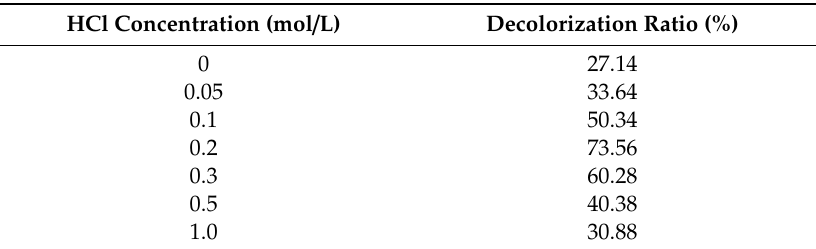
Table 7. E ff ect of HCl concentration on regeneration ratio.